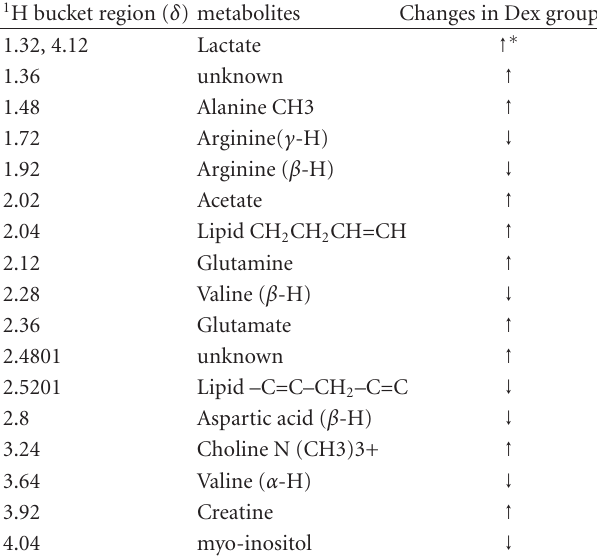
Table 2: the main metabolites changes that were partially responsi- ble for discriminating Dex group from control using